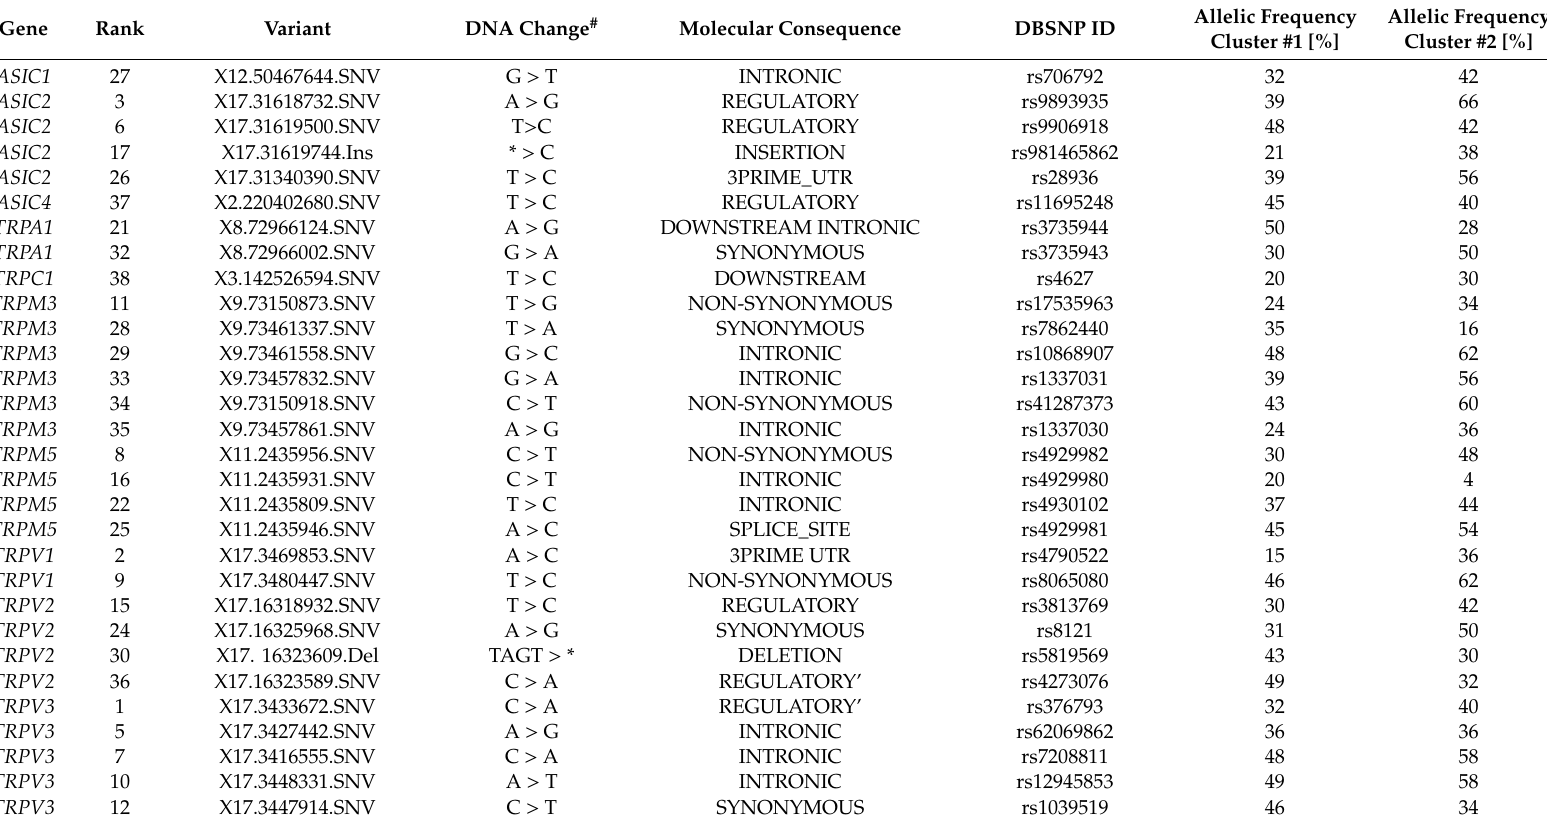
Table 2. Genetic variants that, following feature selection, were included in the genotype–phenotype association, and their potential biological consequences as queried from several publicly available databases (NCBI gene index database at http: // www.ncbi.nlm.nih.gov / gene, GeneCards at http: // www.genecards.org, Short Genetic Variations database (dbSNP) at https: // www.ncbi.nlm.nih.gov / snp, and the “1000 Genomes Browser” at https: // www.ncbi.nlm.nih.gov / variation / tools / 1000genomes; all accessed in January 2020). The putative functional consequences according to [34] are amino acid or protein changes for missense and deletion / insertion variants (indicated in DNA Change by *) and reduced transcriptional e ffi ciency for untranslated region (UTR) and synonymous exonic variants. At the right of the table, the Eigen scores [35] of each variant queried from are shown, followed by the allelic frequencies at which each variant was present in the member of the two phenotypic